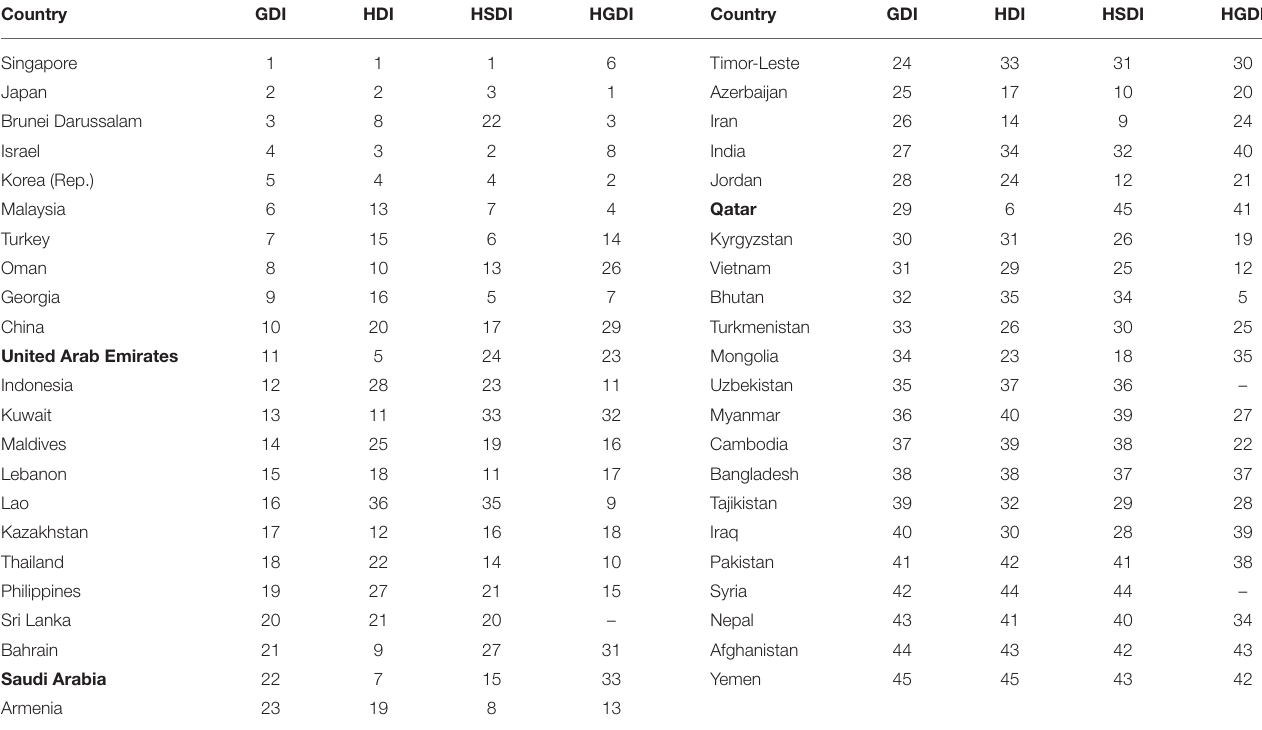
TABLE 6 | The comparison of GDI and other index rankings in 2015.